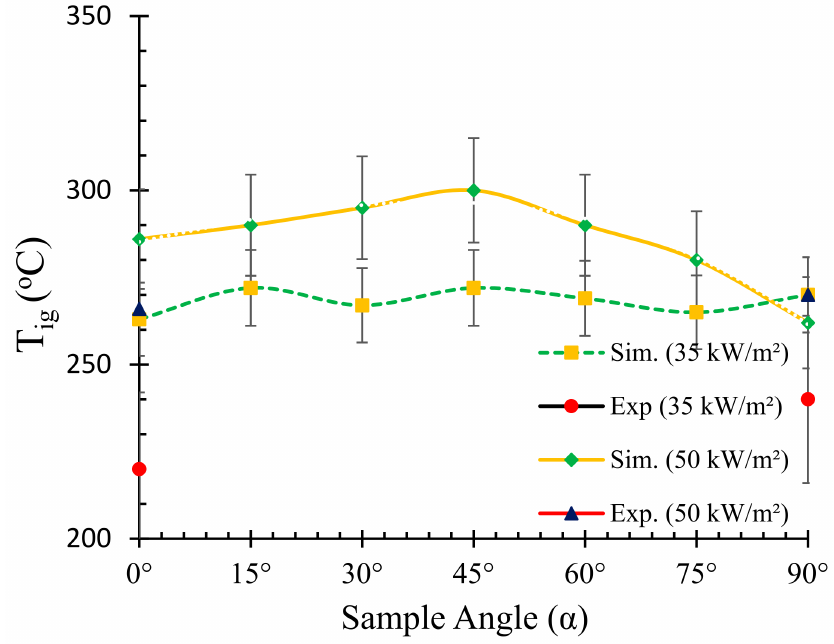
Figure 5. Relationship between the ignition temperature ( T ig ) and sample angle ( α